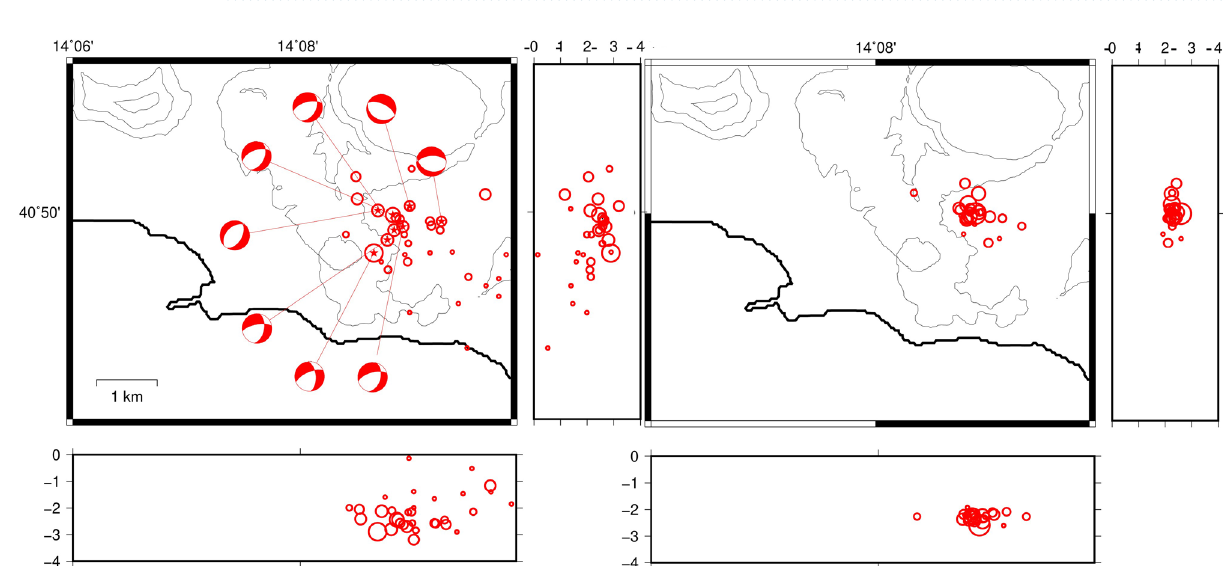
Figure 5. Location of the earthquakes of the swarm of 12/3/2018 obtained using NLLoc (sx) and HypoDD (dx). Circle sizes are proportional to the earthquake magnitude. The images were obtained using the free software GMT 5.3.1 (https:// www. gener ic- mappi ng- tools.